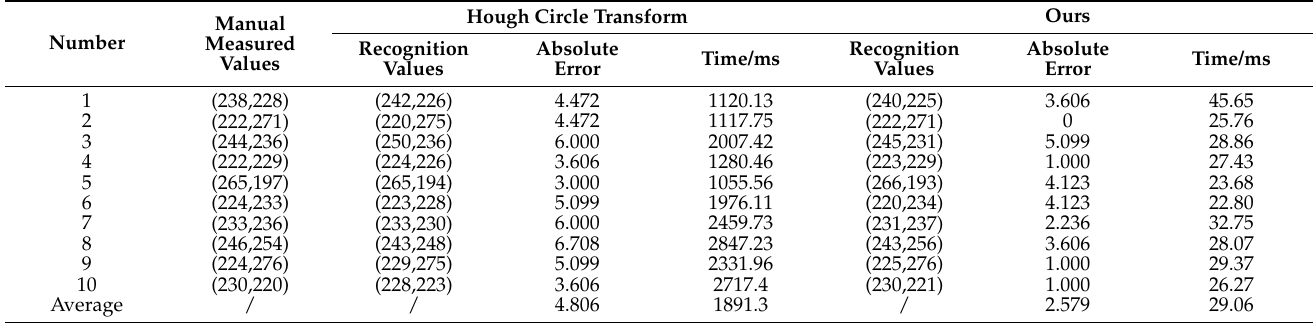
Table 3. Center recognition of ten dial gauges by four methods.